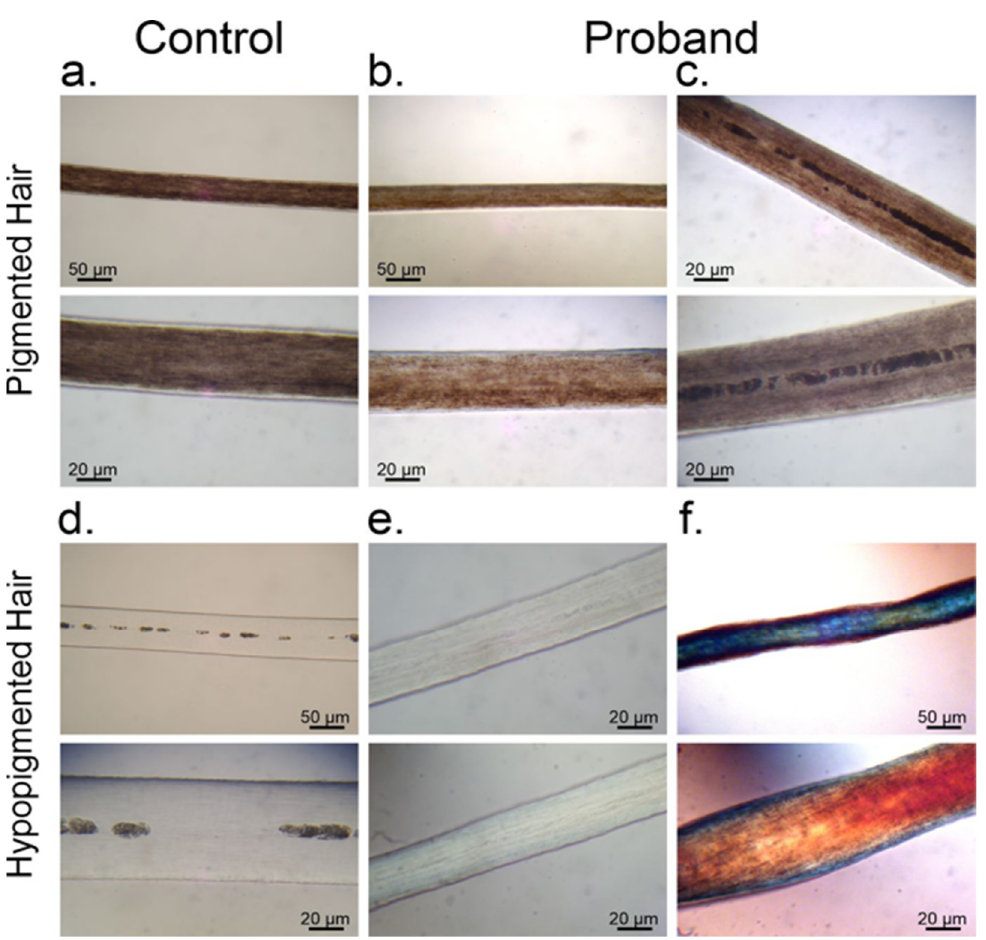
Figure 3. Scalp hair observations by light microscopy. Observations by light microscopy of several hair sections of adult control ( a , d ) and the proband ( b , c , e , f ). Figure shows brown ( a ) and gray hair ( d ) of the same control (male 60 years old not related with the proband). Representative colored hair sections with melanin pigment distributed homogeneously ( b ) and with central pigment accumulation ( c ) are shown. Column ( e ) shows hypopigmented hair section from the case. ( f ) Polarized light microscopic examination of the scalp hair showing pili torti structures in the hair of the